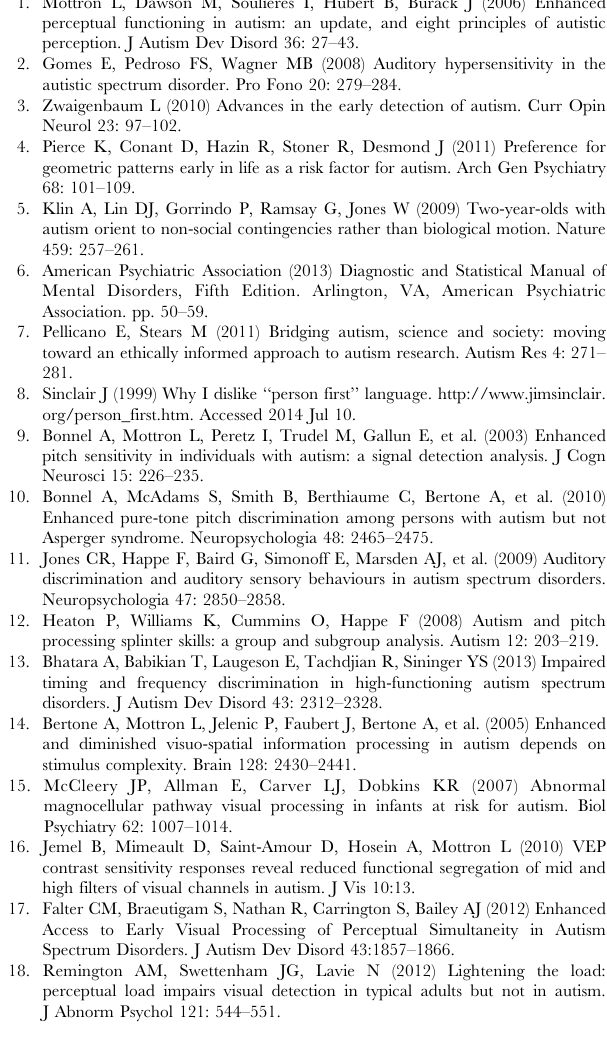
covariate. Table S1 Number of participants excluded a. in each task, because of failure to complete task. Numbers in Table S1.a. also include the 3 autistic and 8 control participants with musical experience who are excluded solely from auditory task (i.e., Pitch and Music), and b. within regression analysis because of residuals . 3 standard